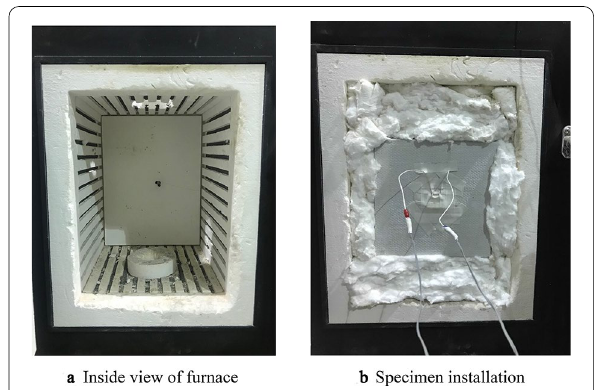
Fig. 25 Thermal conductivity test set‑up of mortar and board (Lim et al. 2017).